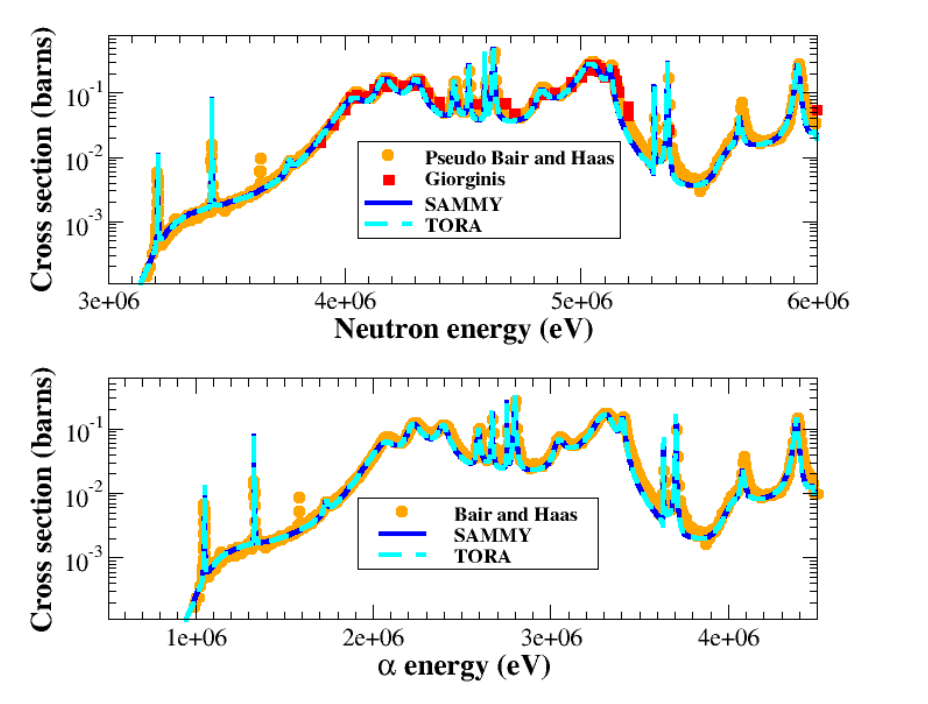
Fig.1. 16 O(n, α ) 13 C (the top subfigure) and 13 C( α ,n) 16 O (the bottom subfigure) unbroadened cross sections versus projectile energy. The long dash curves address the results from TORA. They are compared to reference calculations obtained using the SAMMY-8 (solid curve). On the top sub figure, the pseudo-experimental data are obtained by the inversion of the Bair and Haas 1973 ( α ,n) cross section which are plotted on the bottom subfigure (circular symbols). The forward (n, α ) experimental data (square symbols) are Giorginis (IRMM 2008 [3]) data. The modeling is fulfilled using the Reich-Moore parameters kindly released by L.C. Leal